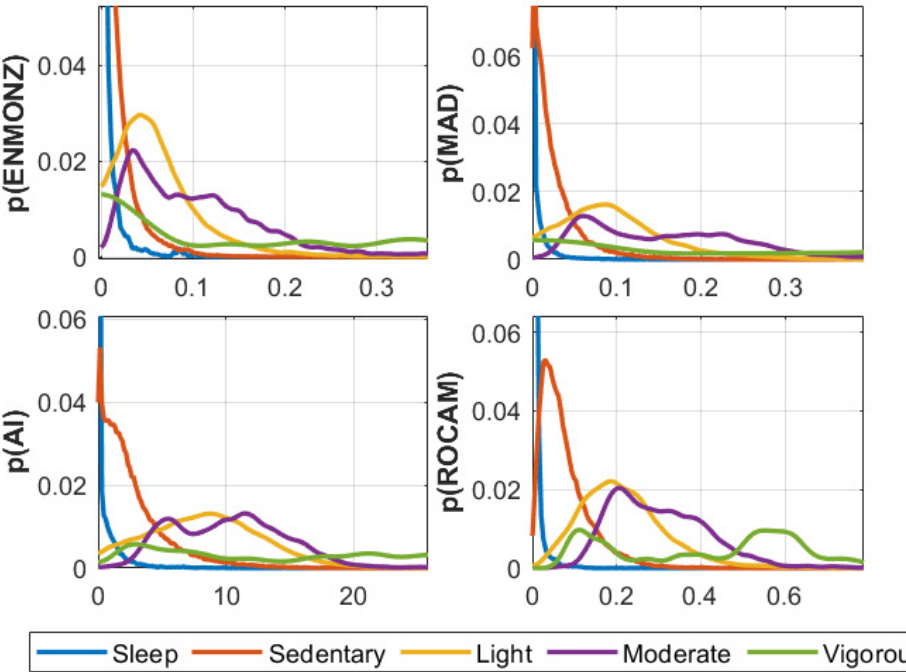
Figure 3. Probability distributions of the four acceleration summary measures (ENMONZ. MAD, AI, and ROCAM) for the five different categories in order to illustrate the distribution overlap. The plots are zoomed in to better appreciate possible thresholds we could be deriving (for an appreciation of the full range of the variable values, see Figure 2d). For brevity, we present only the results with the CAPTURE-24 data sampled at 10 Hz.